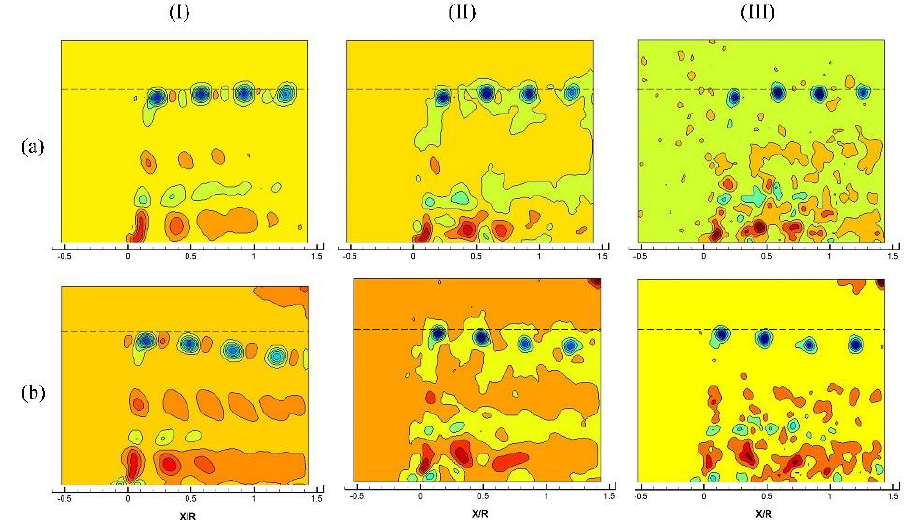
Figure 6. (POD) analysis for time-averaged data: Vorticity contours reconstructed using ( I ) first 5 POD modes (50% of total energy), ( II ) first 50 POD modes (75% of total energy), and ( III ) all 2000 POD modes for different tip clearance ratios ( 𝛿ℎ 𝑈 = 0.55, row a , and 𝛿ℎ 𝑈 = 0.27, row b ).